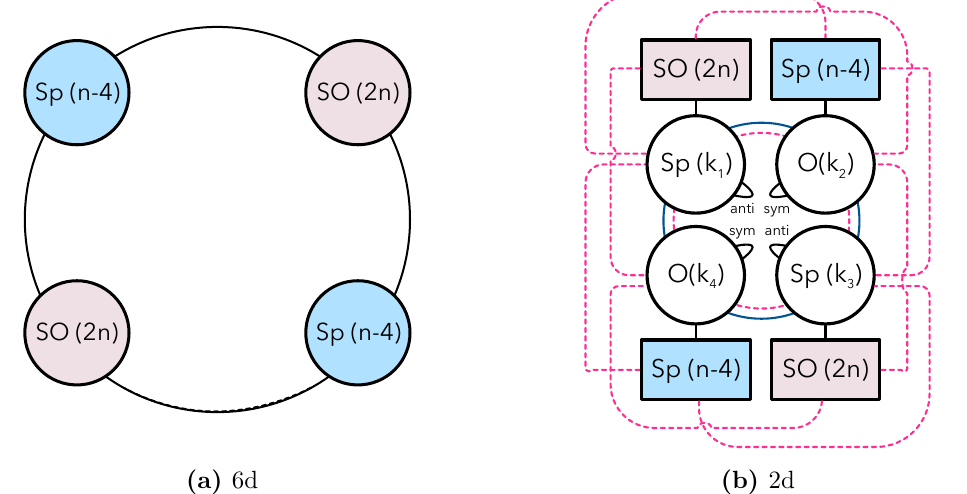
Figure 2. Quiver diagrams for 6d/2d gauge theories on D6/D2-branes at N =